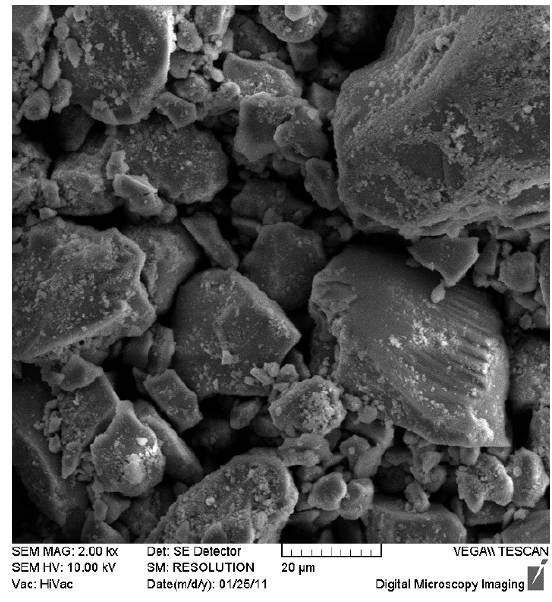
Figure 3. SEM image of an untreated sample.